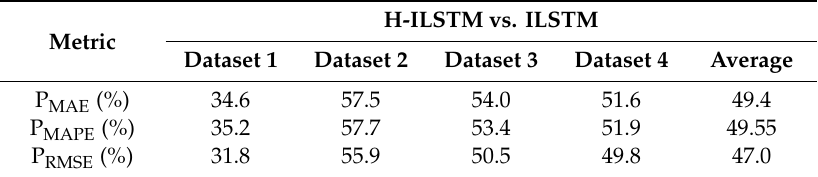
Table 7. The promoting percentages of the ILSTM model by the H-ILSTM model of one-step prediction for the load datasets 1–4.